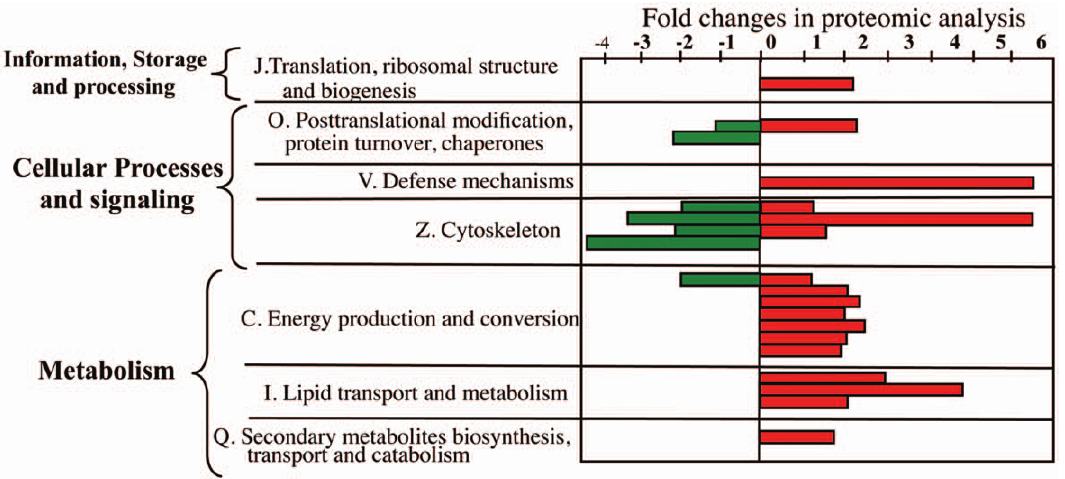
Figure 2. Representation of the functional annotation analysis for KOG of all genes that showed 0.5 fold higher or lower change in protein expression.